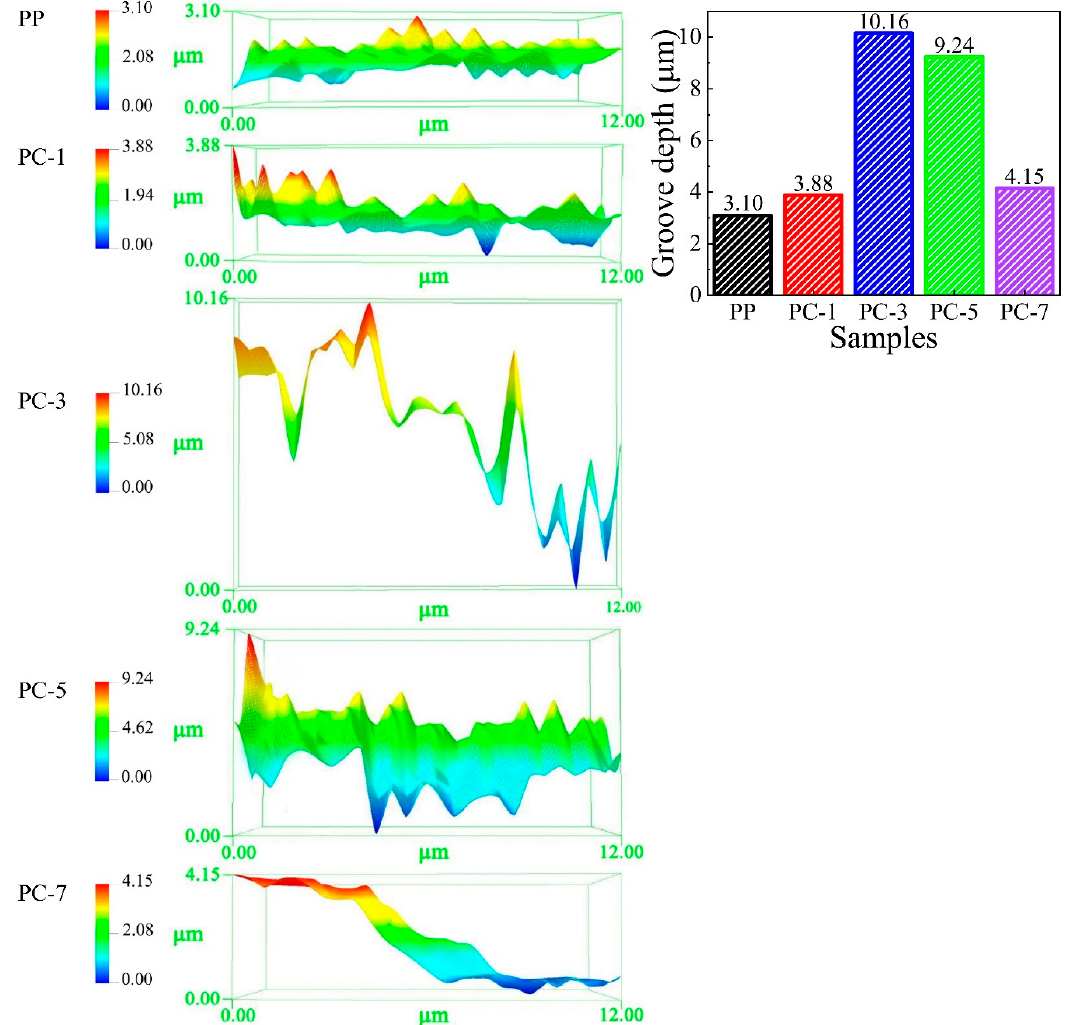
Figure 9. 3D surface morphology and groove depth of PP, PC-1, PC-3, PC-5, and PC-7.